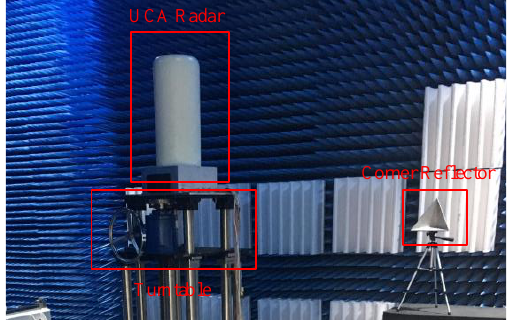
Figure 8. Experiment scenario in the anechoic chamber.